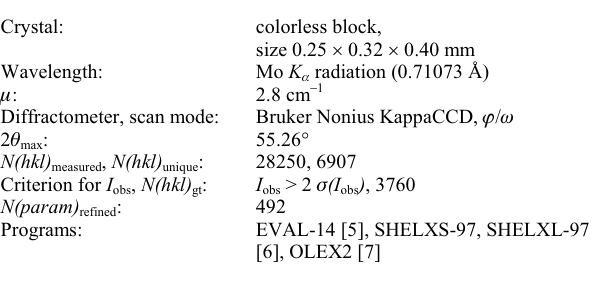
Table 1. Data collection and